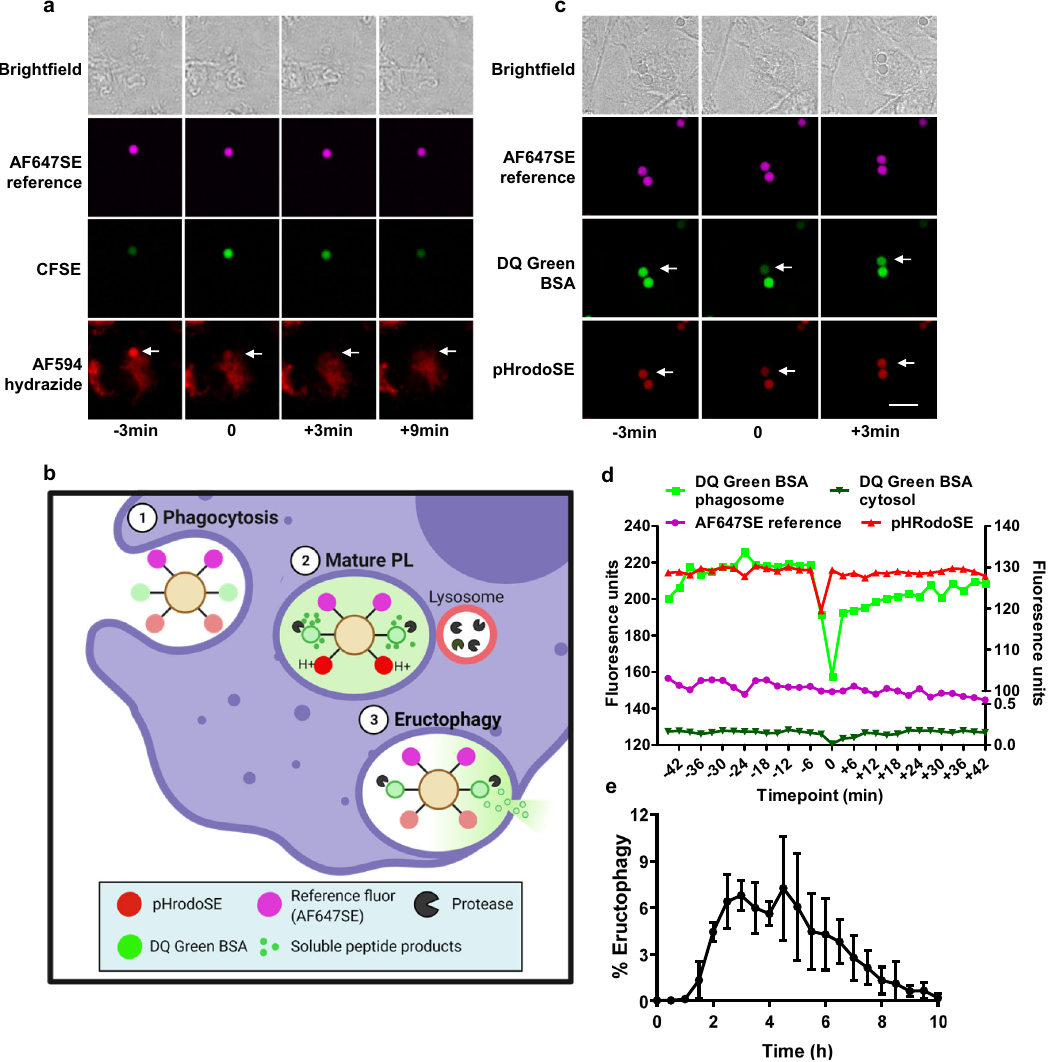
Fig. 2 Transient communication between the extracellular environment and mature phagolysosomes of pro-in fl ammatory macrophages. a BMMØs were pulsed overnight with membrane impermeant fl uid-phase tracer AF594 hydrazide (red) and chased to lysosomes over 2 h prior to the phagocytosis of experimental particles labelled with the pH-sensitive fl uor CFSE (green) and pH-stable fl uor AF647SE (magenta). Sequential images of a phagolysosome containing AF594 hydrazide (by prior fusion with AF594 hydrazide-loaded lysosomes) undergoing transient pH neutralization. AF594 hydrazide fl uid- phase fl uorophore (red) was lost upon neutralization of the phagolysosome (indicated by the transient increase in CFSE fl uorescence on the bead). No increase in cytosolic AF594 fl uorescence could be detected following its loss from the phagolysosome indicating extracellular release. b Graphical illustration of the experimental particle assay used to measure the loss of partially digested particles from phagolysosomes. The particles bear self- quenched DQ Green BSA, pHrodoSE and the reference fl uor AF647SE. c – e Phagosomal proteolysis and pH were monitored in BMMØs following phagocytosis of experimental particles bearing the quenched DQ Green BSA substrate (green), the pH indicator pHrodoSE (red) and the reference fl uorophore AF647SE (magenta). Eructophagy was demonstrated by the simultaneous loss of soluble peptide products of DQ Green BSA (green) and neutralization of the phagolysosome (red), followed by resumption of proteolysis and re-acidi fi cation. d DQ Green BSA phagosome and DQ Green cytosol are plotted on the right axis. AF647SE reference and pHRodoSE are plotted on the left axis. e Data are presented as the percentage of phagosomes that underwent ≥ 1 eructophagy event within the corresponding 10 h period post-phagocytosis. Error bars presented as means ± SEM from n = 3 independent experiments. Images were captured using an IN Cell Analyzer 2000 between 90 min and 3 h postphagocytosis at 37 °C. Time 0 represents an eructophagy event. Scale bars denote 10 μ m. Source data are provided as a Source Data fi